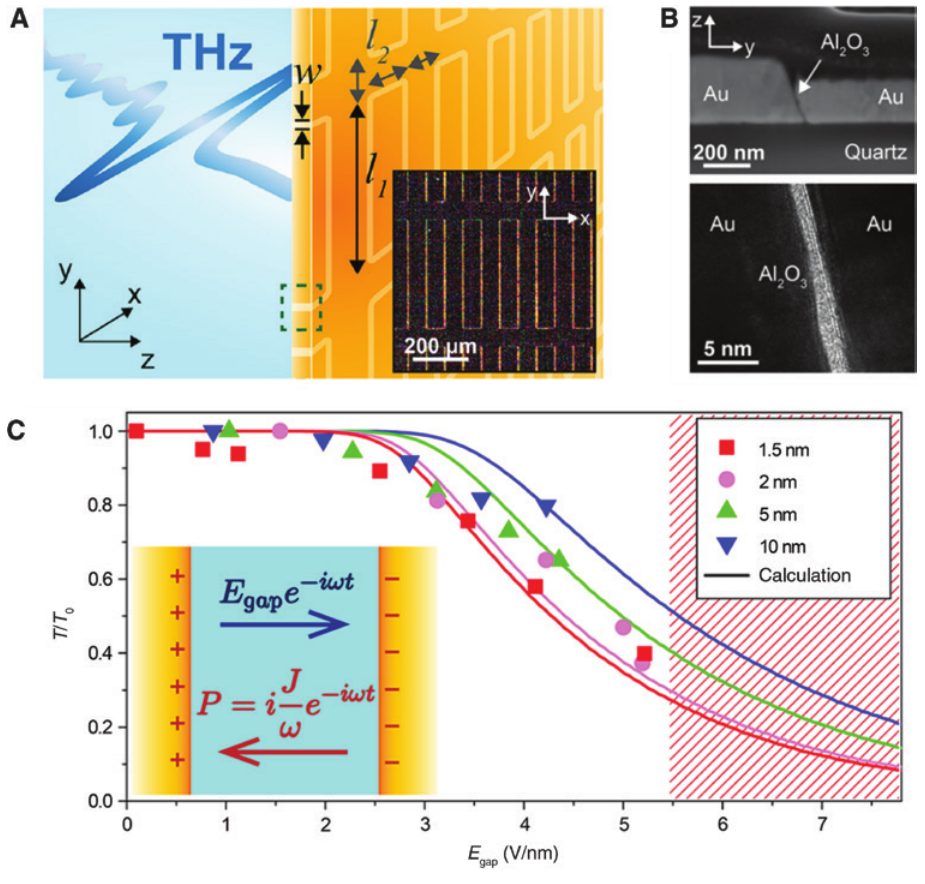
Figure 21: Nonlinearity in THz transmission through nanogaps. (A) Optical micrograph image of arrays of nanoslot of 10 nm gap size. (B) Cross-section image of a 1.5-nm-wide gap from an SEM (top) and an STEM of the Al O layer between gold (bottom). (C) THz transmittance with varying electric field amplitudes inside the gap. The dashed 2 3 region (right) indicates where the gap is damaged by the induced electric field. This figure is reproduced from Ref.